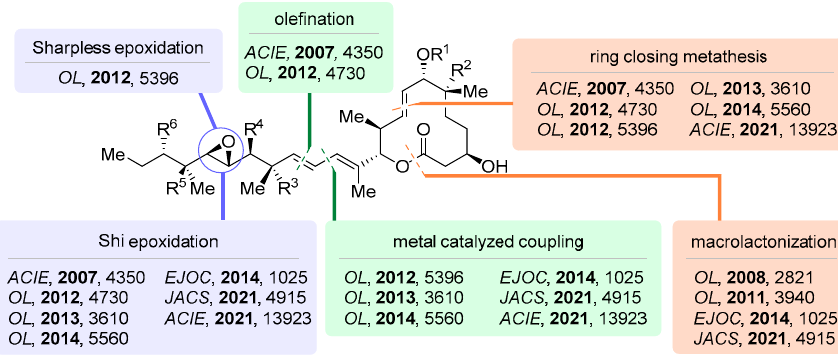
Figure 3. Brief summary of the disconnections of pladienolides as reported, 2007–2021.